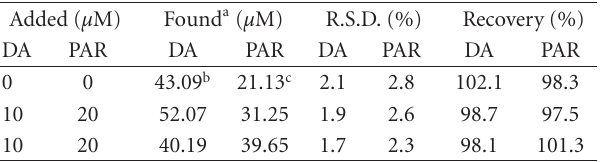
Table 3: Table Determination of DA and PAR in in injection and tabelt sample with